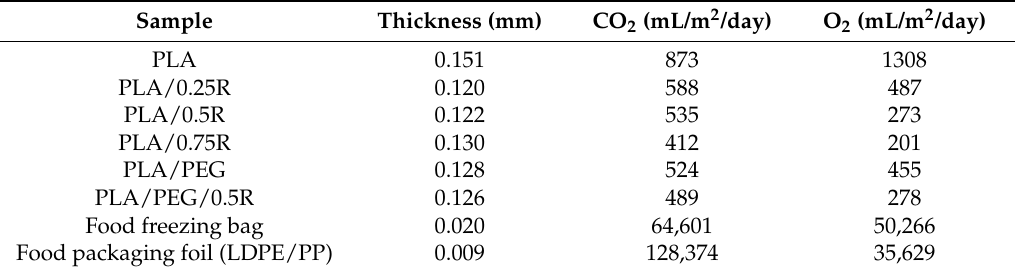
Table 8. Permeability of tested films to CO 2 (~4 h to equilibrium) and O 2 (~7 h to equilibrium).